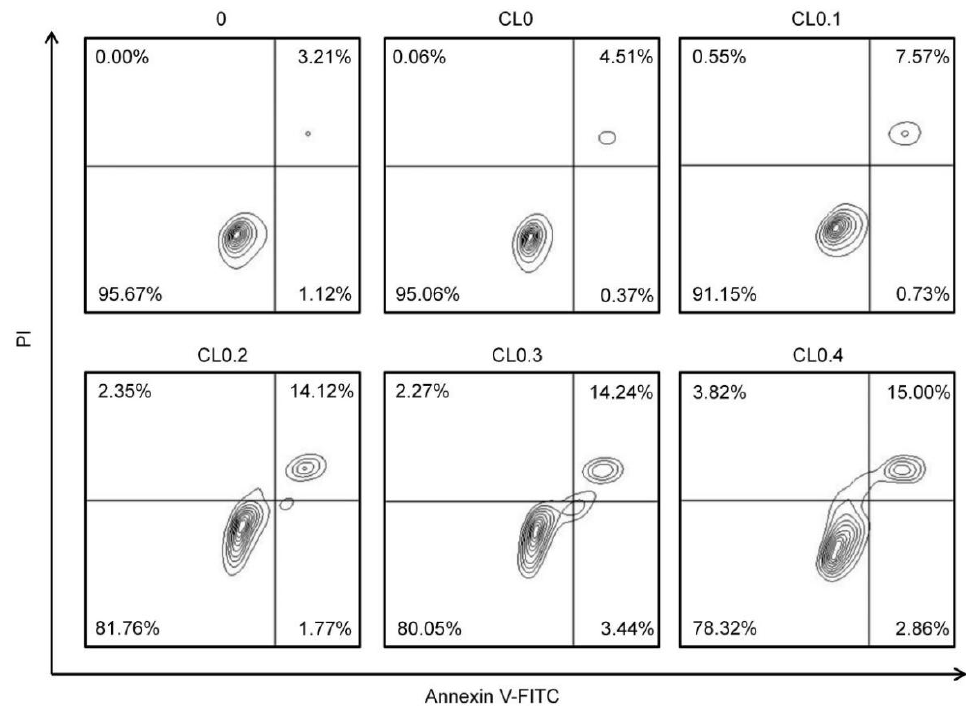
Figure 5. Relative viabilities of NIH 3T3 cells and HPAEpiCs after incubation with different CLs for 5 and 24 h. ( a ) NIH 3T3 cells, 5 h, ( b ) HPAEpiCs, 5 h, ( c ) NIH 3T3 cells, 24 h, ( d ) HPAEpiCs, 24 h.